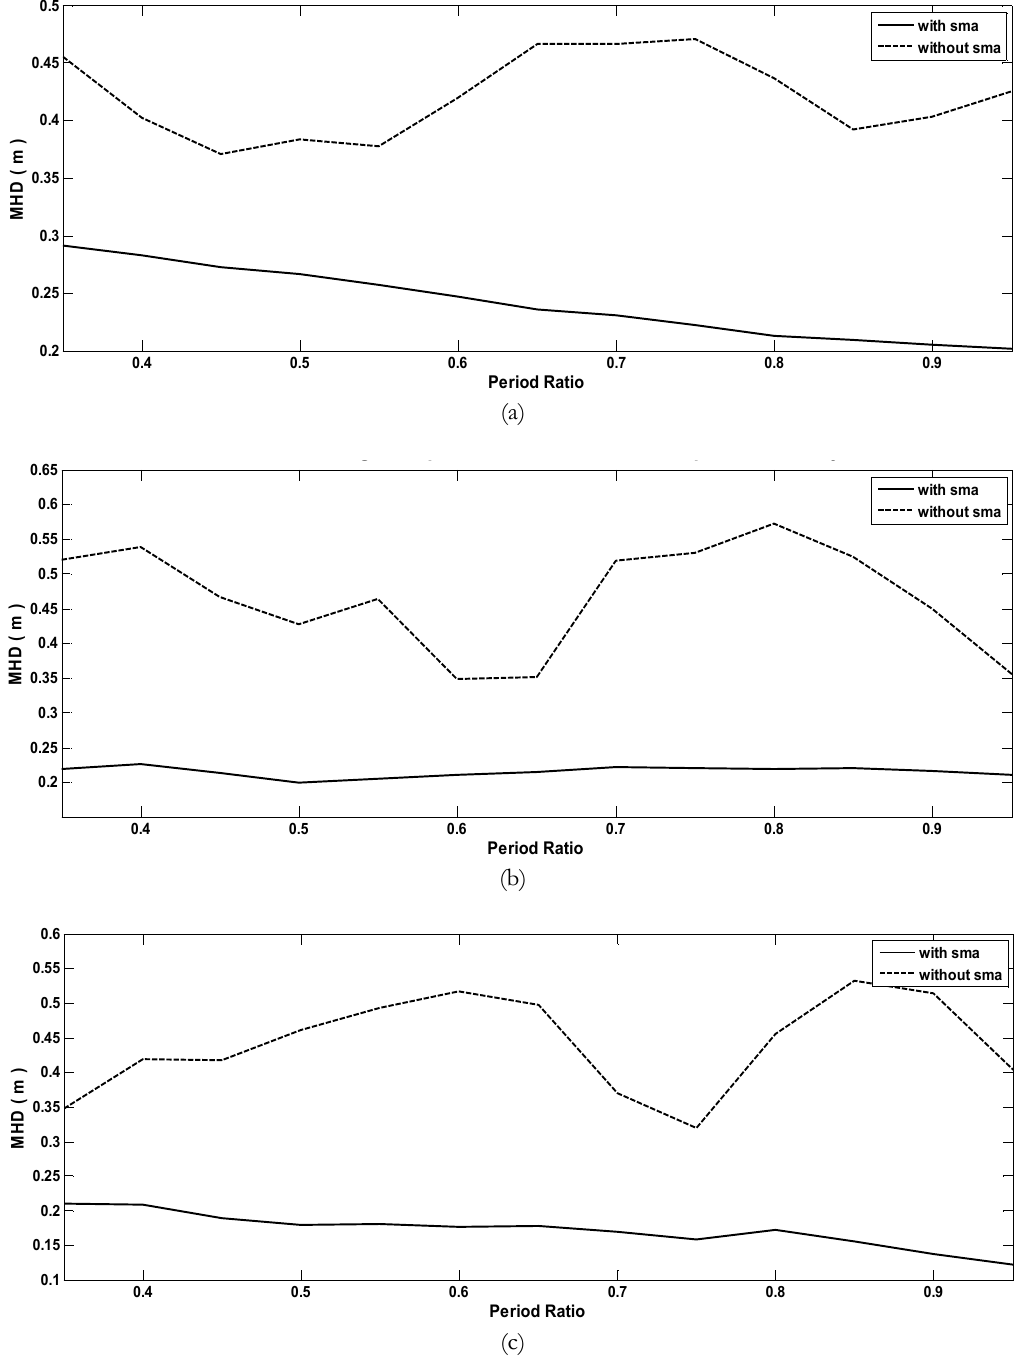
Figure 12: Comparison between MHD when using SMA and as–built bridge at various period ratios for the three hinges taking delay effect, (a) Hinge 1; (b) Hinge 2; (c) Hinge